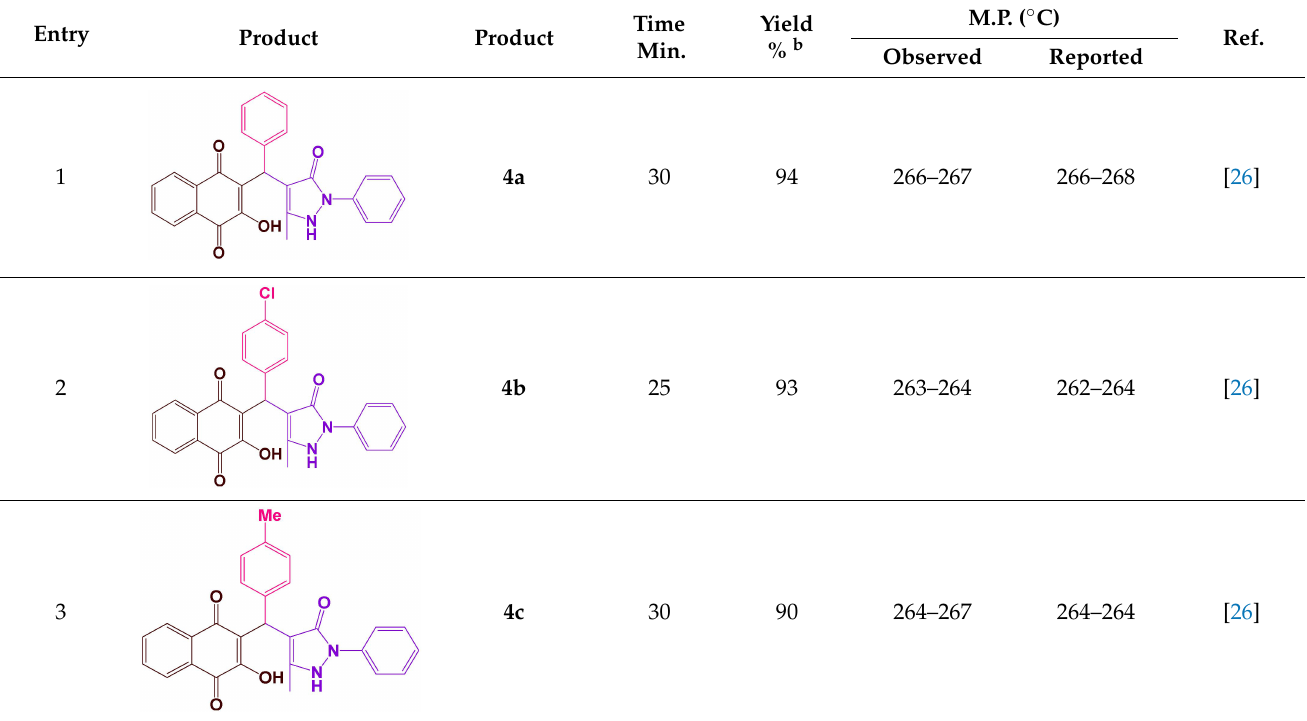
Table 3. Conversion of benzaldehyde derivatives to benzyl pyrazolyl naphthoquinone in the presence of MSMF a